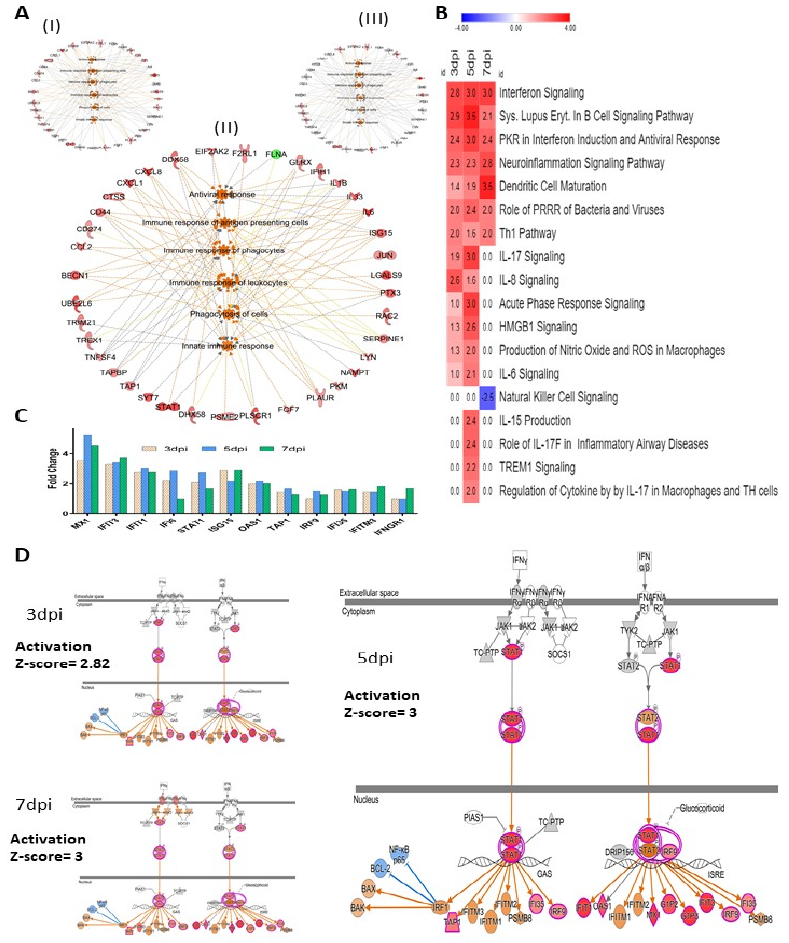
Figure 5. Immune response in HSerC after ZIKV infection. ( A ) Bio-functions related to immune response pathways affected at (I) 3 dpi, (II) 5 dpi, and (III) 7 dpi. ( B ) Canonical pathways associated with immune response pathways affected by ZIKV infection in Sertoli cells. Red and blue represent up-regulation and down-regulation, respectively. The number in each box shows the activation Z-score predicted by IPA. ( C ) Proteins in Interferon signaling pathways affected by ZIKV infection. ( D ) Activation of Interferon signaling pathway by ZIKV infection. Red and green represent up- regulation and down-regulation, respectively; gray proteins denote that they were recognized in the present study, but not significantly regulated; colorless proteins interact with molecules in the network, but were not identified in our study. Abbreviations. dpi = Days post